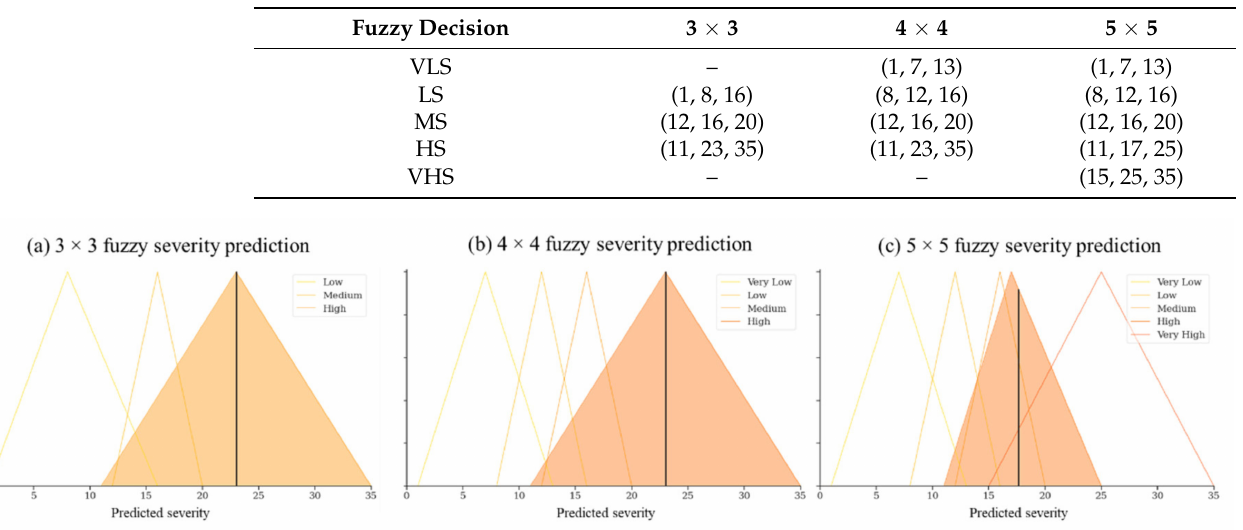
Figure 12. Sample fuzzy decision making, integrating customized AutoML with expert judgment.